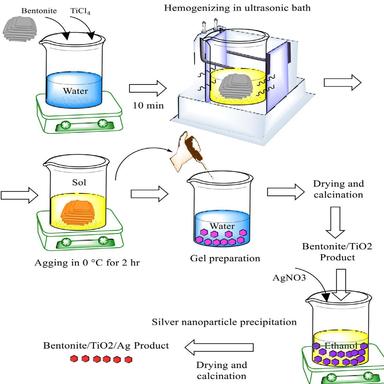
Schematic of the preparation stages of the photocatalysts, and photocatalytic mechanism of the dye degradation in the presence of UV irradiation and hydrogen peroxide with the prepared nanophotocatalyst.